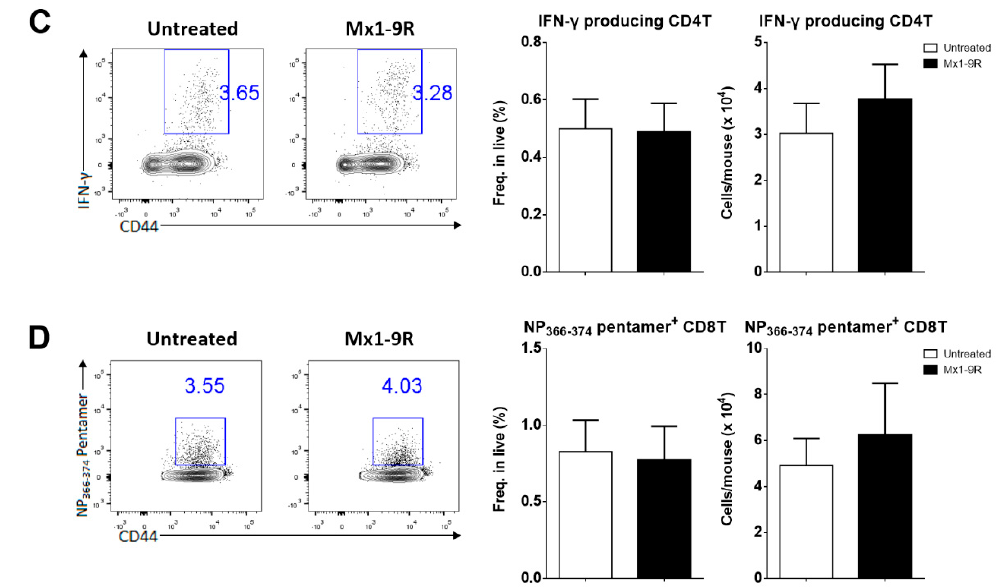
Figure 4. Protein transduction domain (PTD)-fused Mx1-9R improved the survival of influenza PR8-infected mice. Mx1-9R was intranasally administered to mice one day prior to the day of infection. Mice were infected by intranasal application of 25 PFU of PR8 virus. ( A ) Body weight loss and survival were measured according to the Kaplan–Meier method ( n = 4–5). ( B ) Viral titers in BAL fluid were measured by plaque assay ( n = 4–5). ( C ) Intracellular IFN- γ staining and ( D ) NP 366–374 antigen-specific CD8 T-cell staining were performed to analyze the T-cell responses at 8 days post-infection ( n = 4–6). Data are presented as the mean ± SEM.